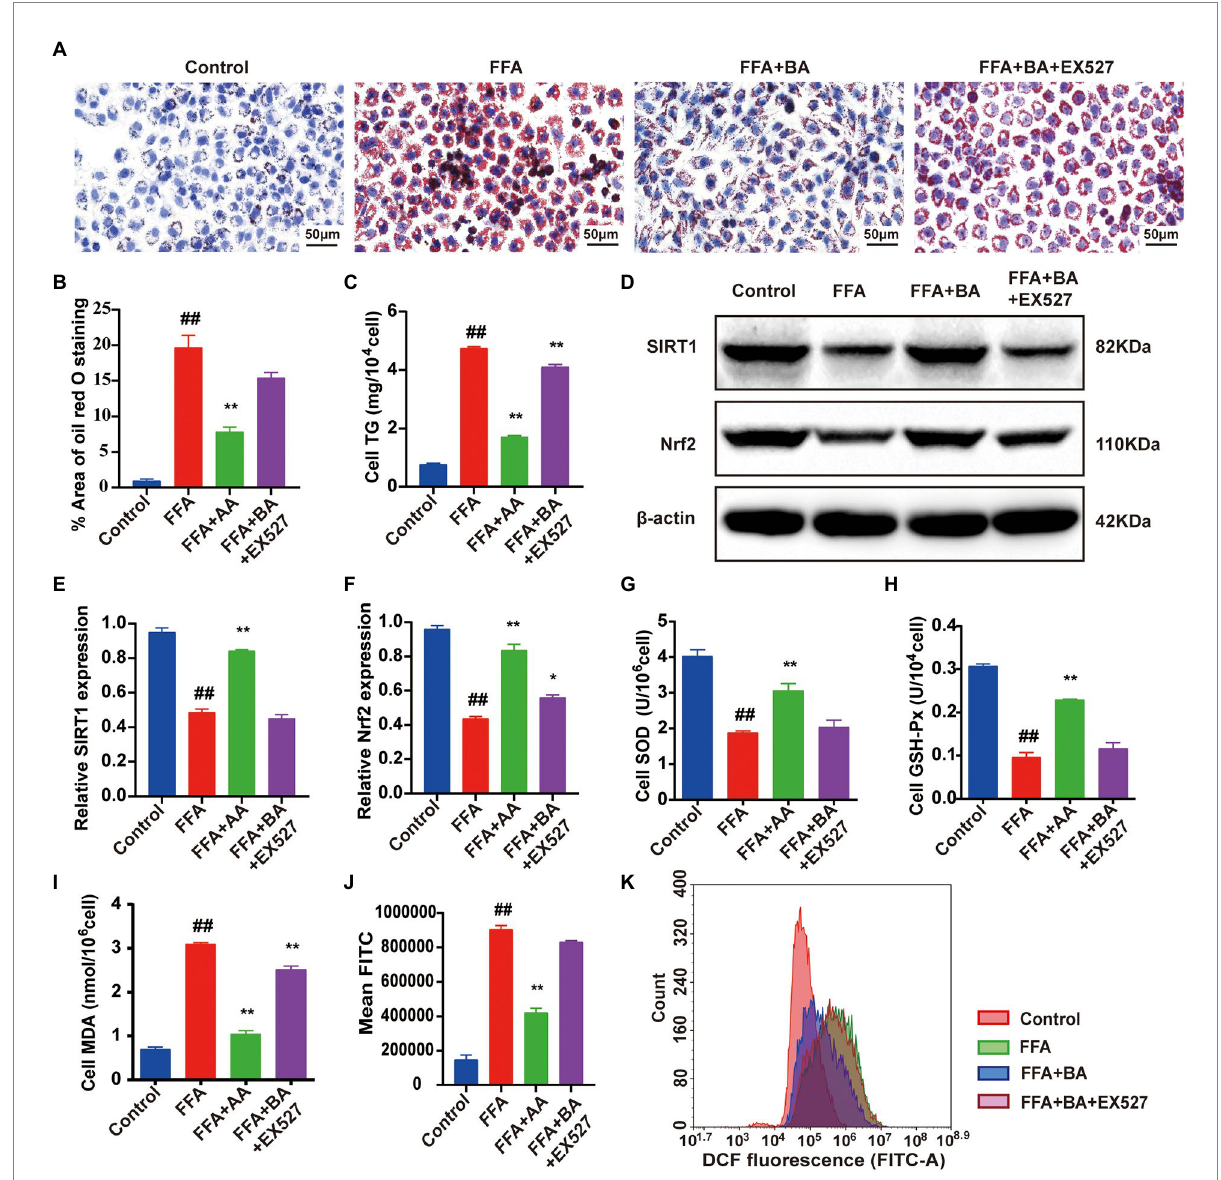
FIGURE 9 Butyric acid ameliorated FFA-induced L02 cells oxidative stress injury via the SIRT1/Nrf2 pathway. (A) Cell Oil red O staining (magnification, ×400). (B) Quantitative analysis of oil red staining results was performed using Image Pro Plus 6.0 software. (C) Cell TG level. (D–F) Western blot analysis of SIRT1 and Nrf2 in L02 cells. (G–I) The level of cell SOD, GSH-Px and MDA, respectively. (J,K) Histogram of intracellular ROS level detected by DCFH-DA. L02 cells were pre-treated for 24 h with 1.0 mM FFA to constructed NAFLD cell model before treated with 0.5 mM BA or 100 nM EX-527 for another 24 h. Data represent means ± SEM. ## p < 0.01 versus Control; * p < 0.05, ** p < 0.01 versus